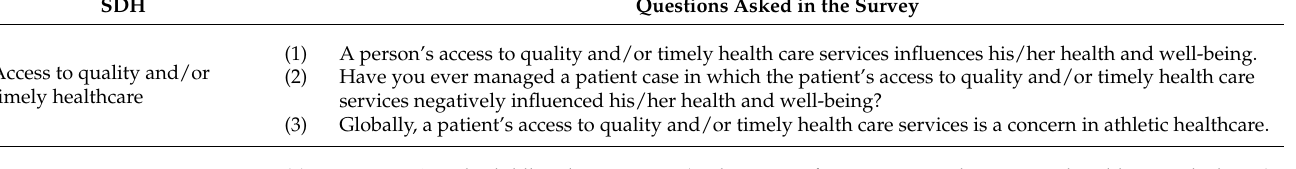
Table 1. Survey questions about athletic trainers’ perceptions of and experiences with social determi- nants of health